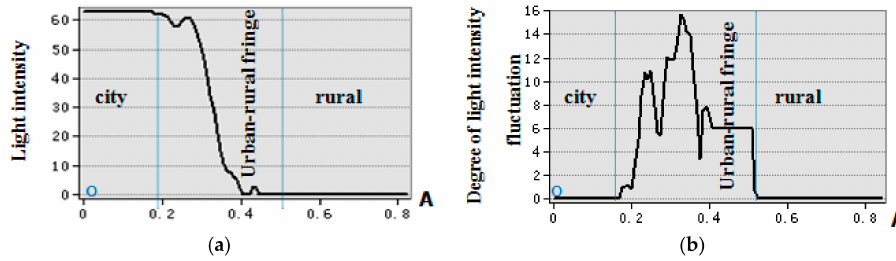
Figure 3. Characteristics of light intensity ( a ) and degree of light intensity fluctuation ( b ).